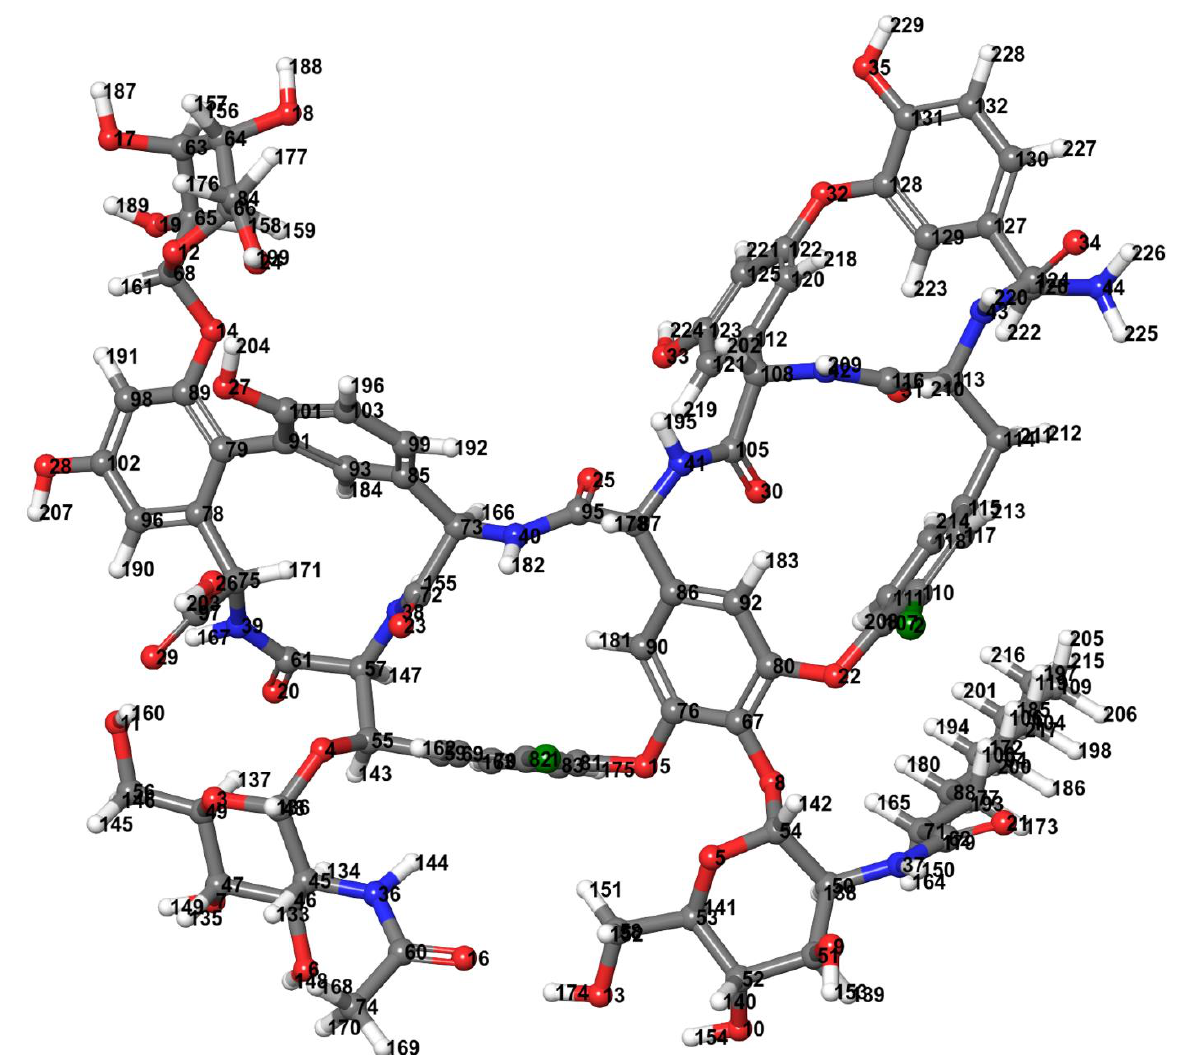
Figure 3. Teicoplanin structure optimized by density functional theory (DFT) with Becke’s three-parameter hybrid model, the Lee–Yang–Parr (B3LYP) correlation functional method at 6-31G level (Jaguar v10.9 software of Schrodinger Suites 2020-3 was used). Color code: carbon — dark gray, hydrogen — light gray, nitrogen — blue, oxygen — red, and chlorine — green.